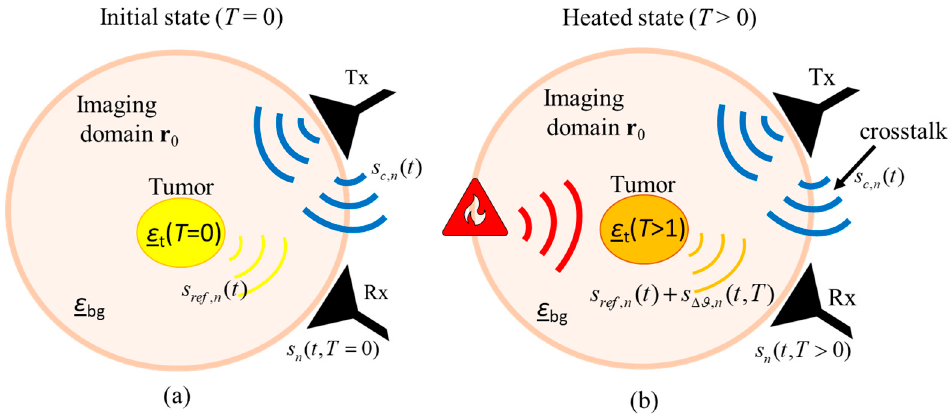
Figure 2. Schematic of the measurement scenario of temperature estimation during hyperthermia by means of UWB sensing ( a ) before start of treatment and ( b ) during treatment.